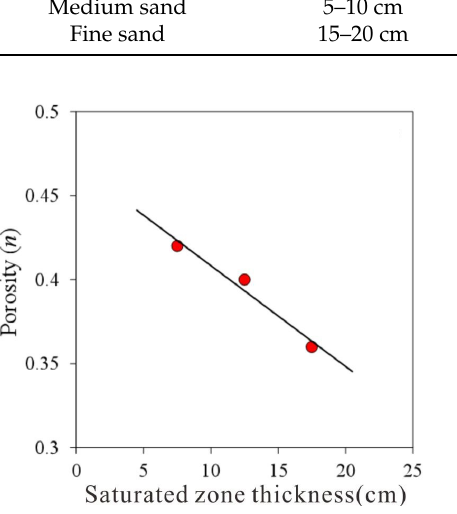
Figure 15. Relationship between inverted saturated zone thickness and porosity.